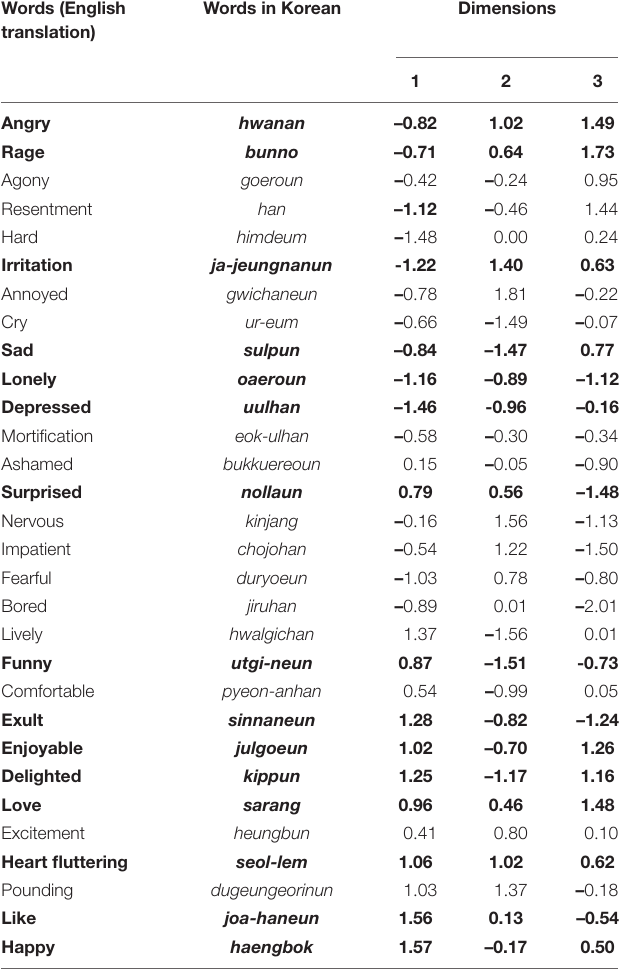
TABLE 2 | MDS scores of emotion words in